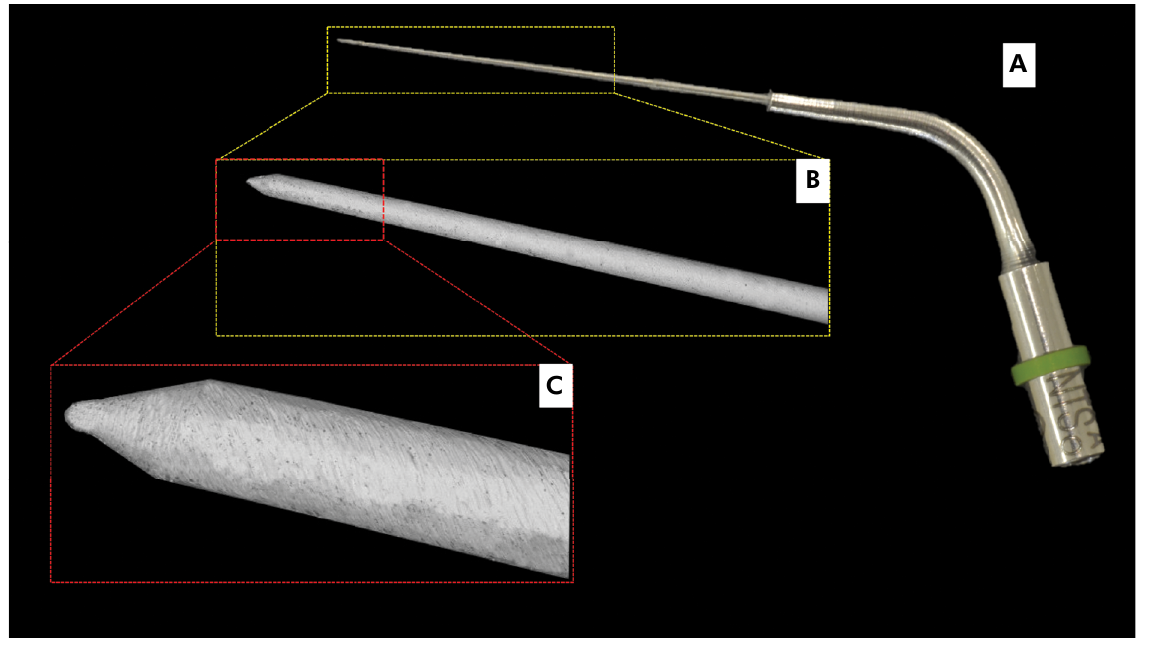
Figure 1. The ultrasonic nickel-titanium tip NiTiSonic ® (A); SEM images at 30x magnification (B) and at 150x (C), evidencing the smooth surface and the noncutting